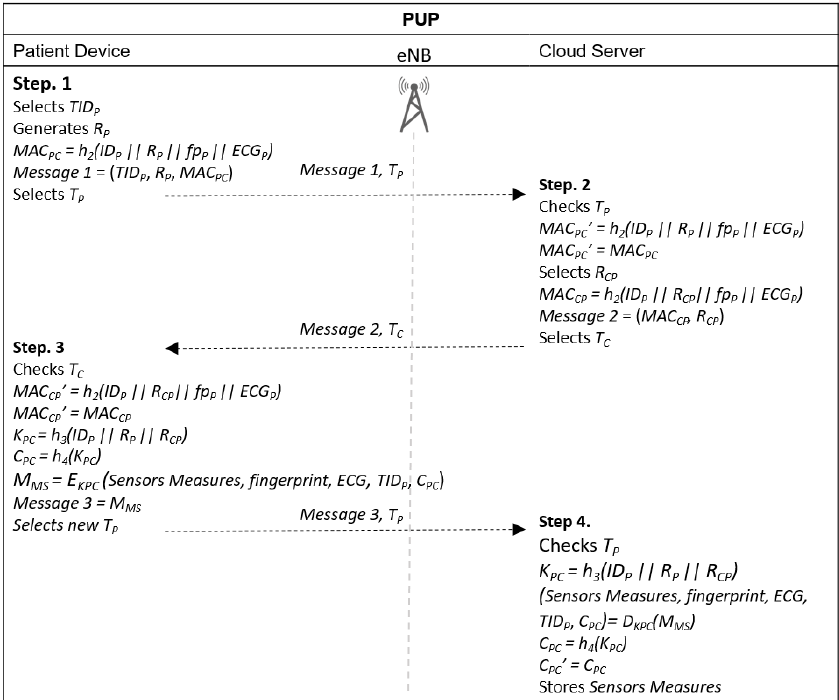
Figure 3. Message exchange in patient upload (PUP) for direct access to 3GPP infrastructure.